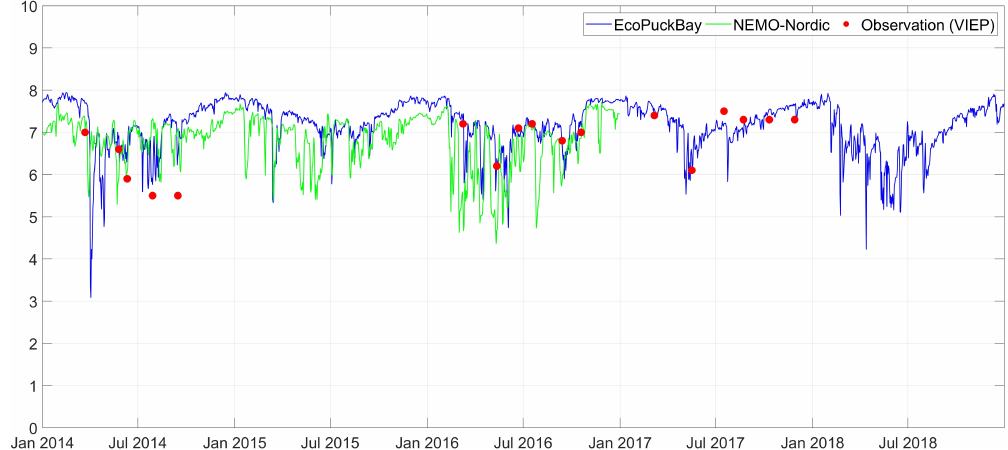
Figure A10. Time series of surface salinity on station OM1 compared with VIEP observations and NEMO-Nordic